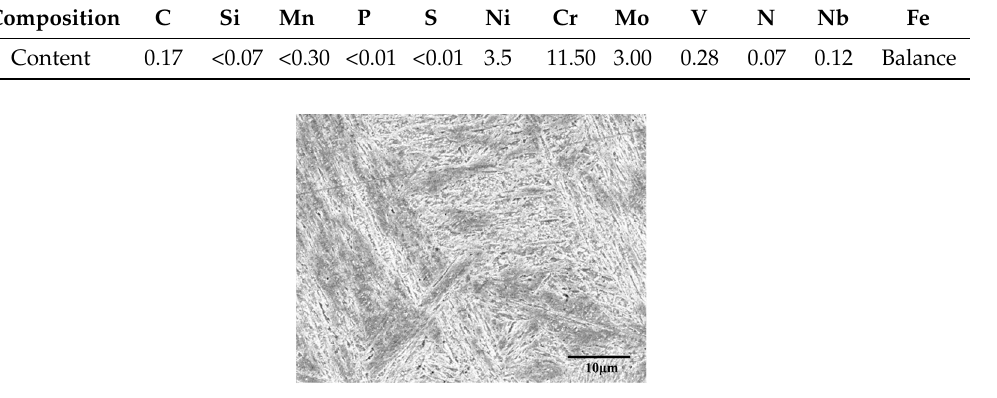
Table 1. The chemical composition of the sample material.